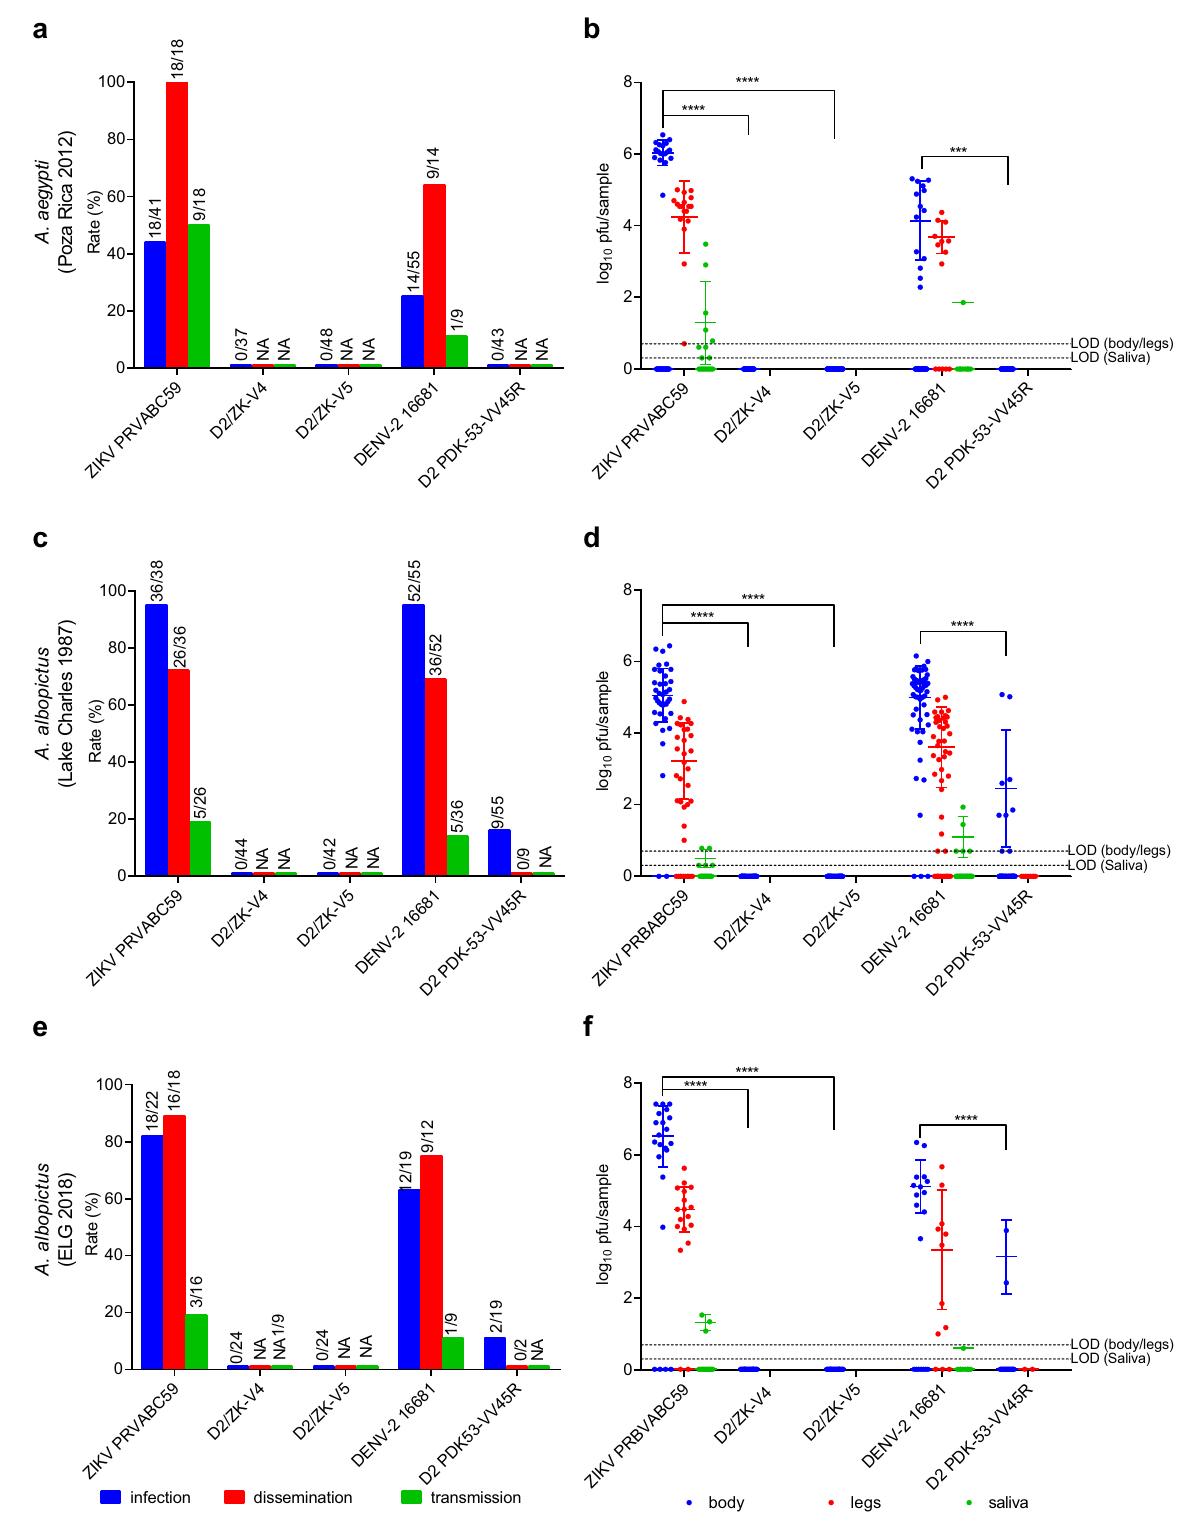
In contrast, all D2/ZK-V5 immunized animals (both single- and double-immunization groups) were fully protected without any detectable viremia, weight loss, or illness. We next evaluated safety and compared the immunogenicity and ef fi cacy of a single immunization (at 10 4 and 10 3 pfu doses) of all D2/ZK-V vaccine candidates (Fig. 7). Unlike wt ZIKV that is lethal for adult AG129 mice at 10 4 pfu, all D2/ZK-V viruses and